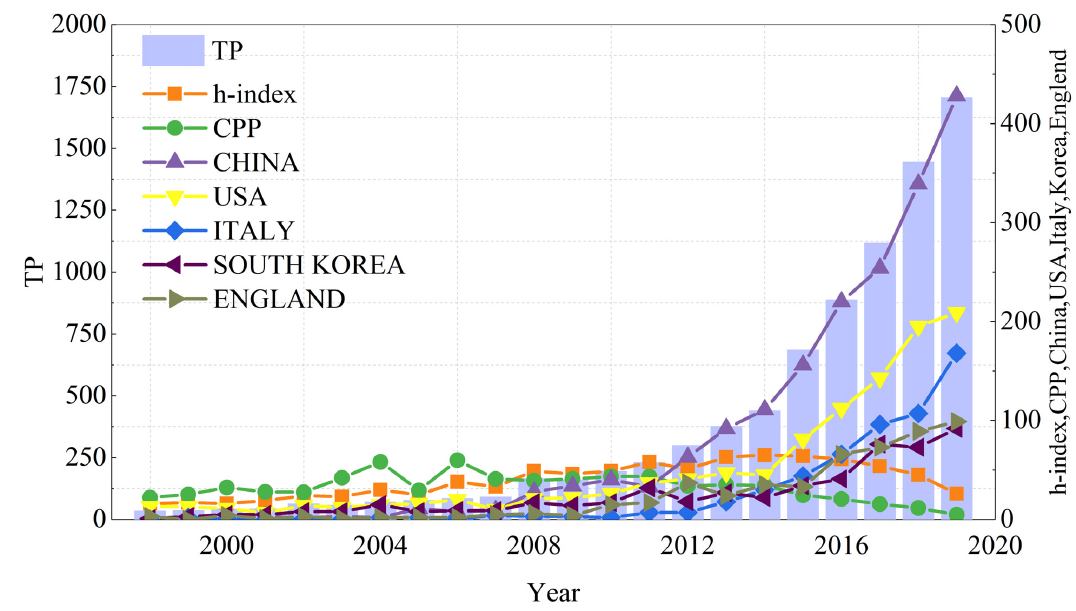
Figure 1. Annual variation curves for total annual publications (TP), h-index, citations per paper (CPP), China, USA, Italy, South Korea, England.